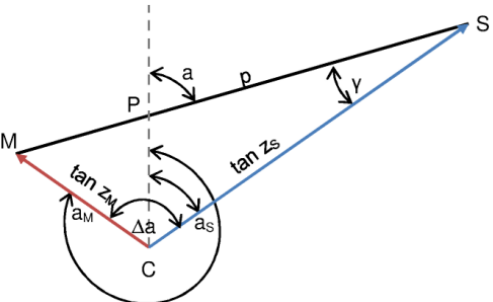
Figure 3. The scheme of the lines of sight (lines connecting points MC and CS) projected to the horizontal plane from two satellites (in colour) forming the corresponding parallax p (MS); both lines of sight are presented as vectors that start in the nadir point of the cloud C and end at the position observed by the satellites (M and S, for MVIRI and SEVIRI, respectively). The zenith and azimuth angles to the satellites are known for both points and the azimuth a of the parallax needs to be